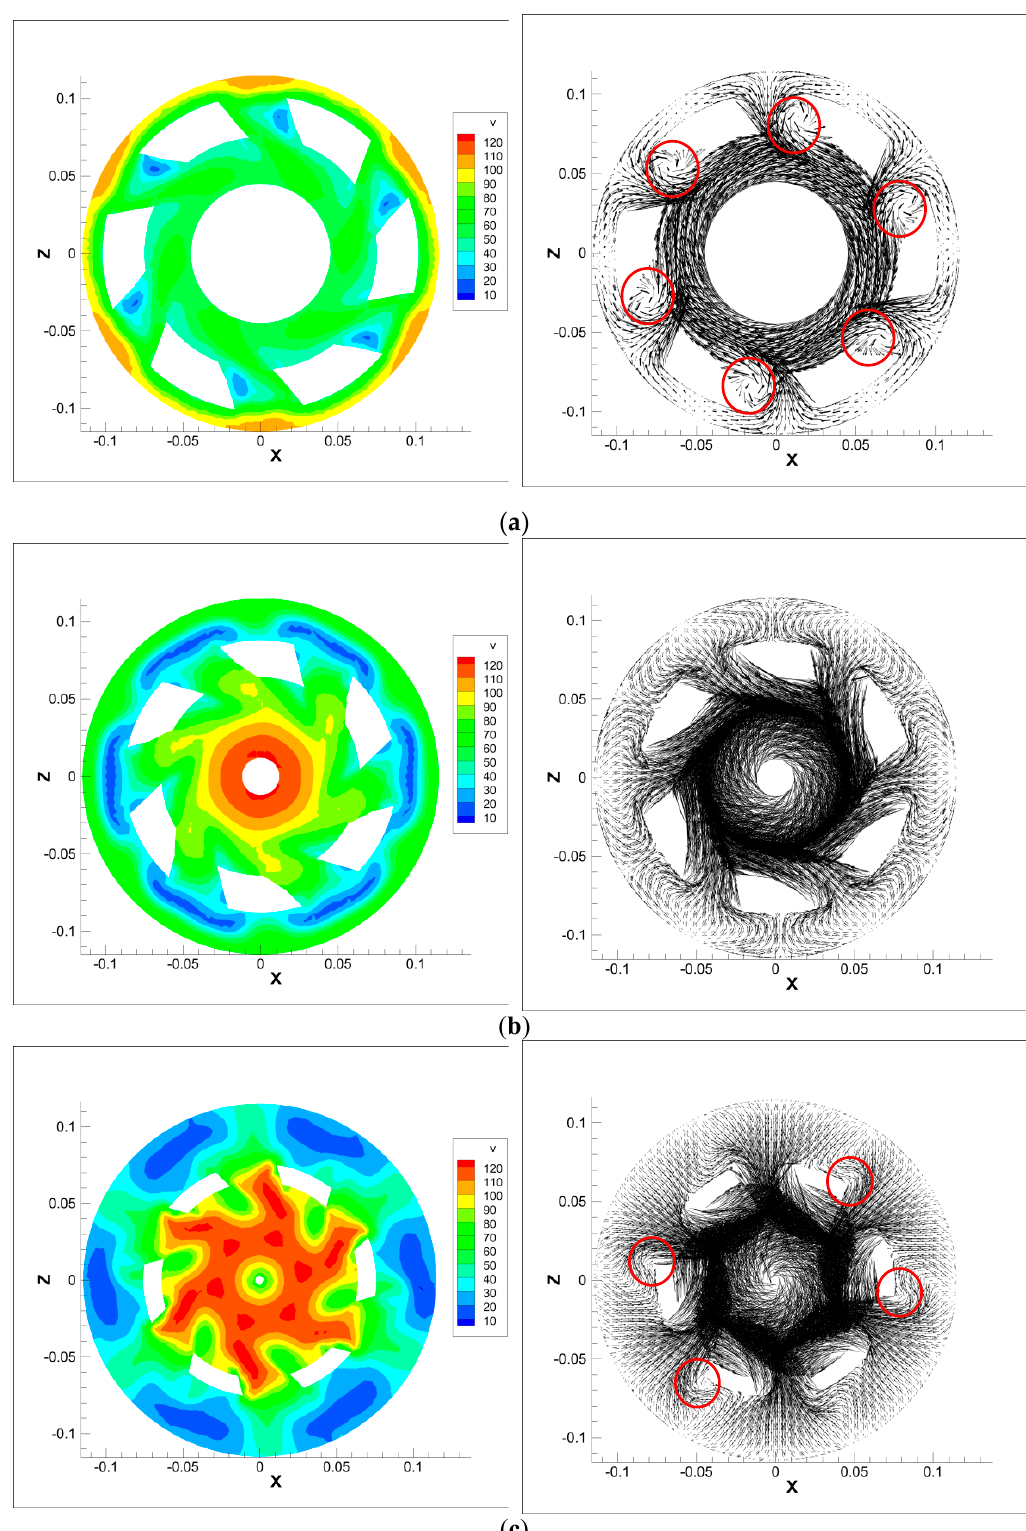
Figure 5. Numerical simulation results of cyclone nozzles simulated by the pre-modified model: ( a ) velocity contours and vector diagrams of the first layer of cyclone nozzle; ( b ) velocity contours and vector diagrams of the second layer of cyclone nozzle; ( c ) velocity contours and vector diagrams of the third layer of cyclone nozzle.